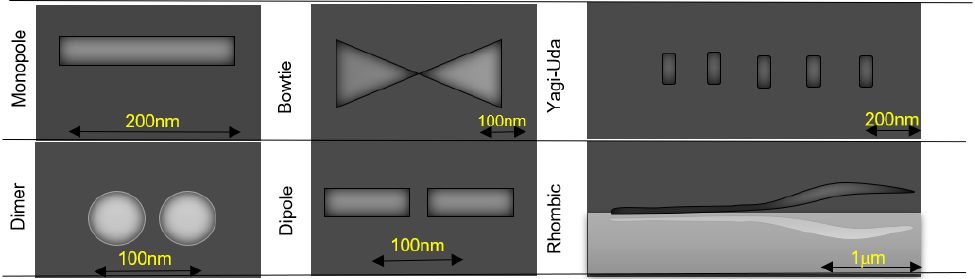
Figure 2. Main types of plasmonic nanoantennas (adapted from the work in